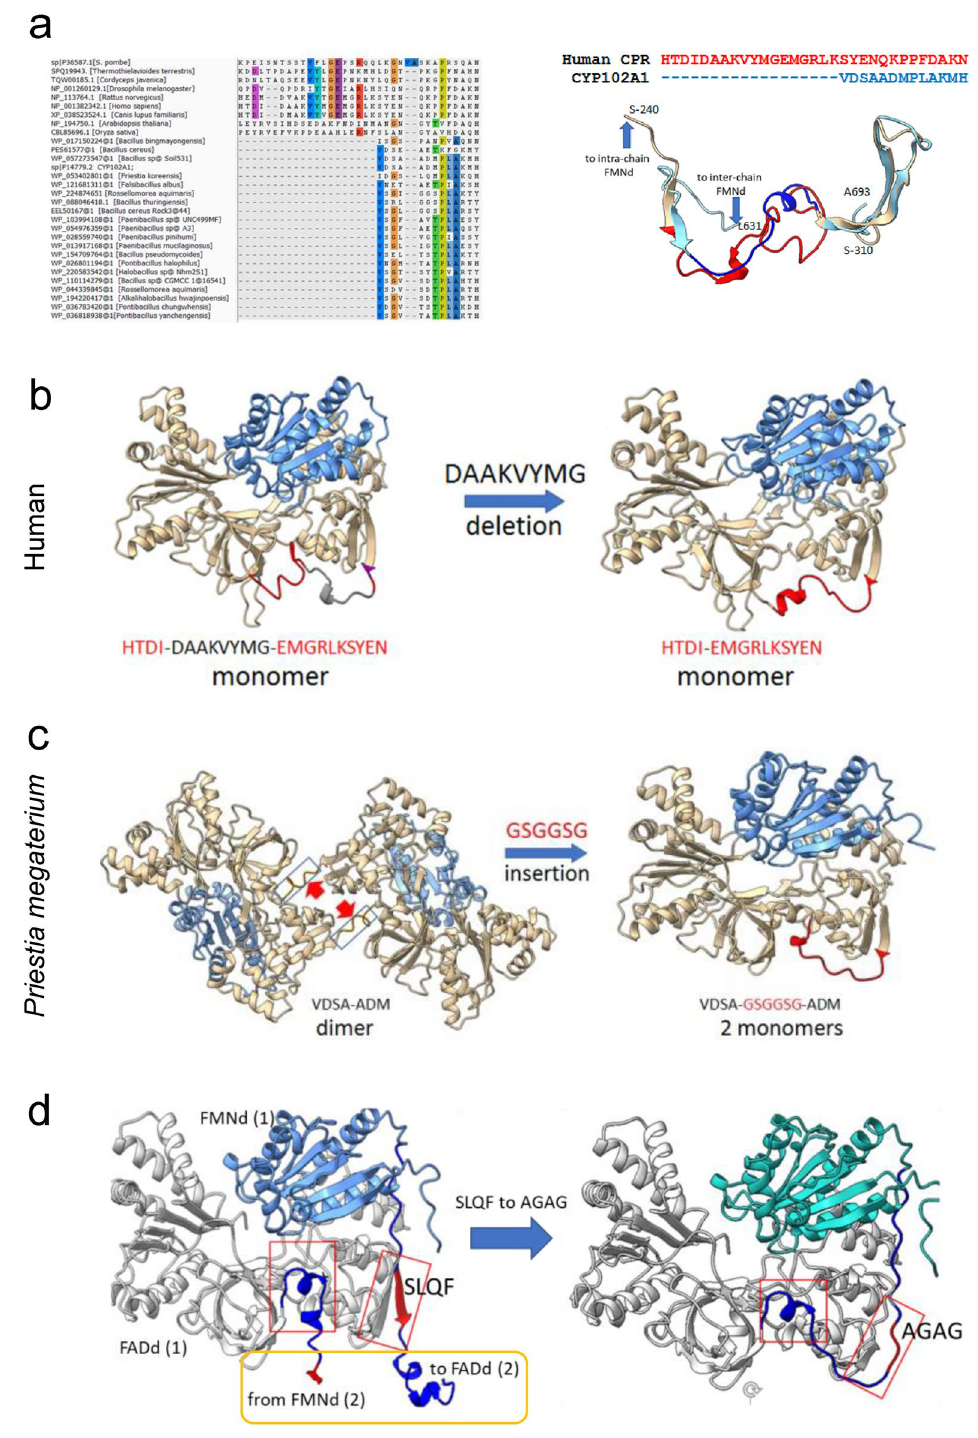
Figure 6. Structure determinants for dimerization identified by in silico mutations of human CPR and bacterial CYP102A1. ( a ), Sequence (left) and structural (right) alignments for the FMNd-FADd interdomain linker region of bacterial and eukaryotic diflavin reductase domains. Structure for human CPR (PDB 3qe2) from Ser240 to Ser310 (colored in wheat) with His250 to Asn280 part is red. The corresponding modeled structure for CYP102A1 is in pale blue with the Val648-His660 in dark blue. The common β-sheet used as alignment limits are visible on the right and left part of the red and deep blue parts. ( b ), Structural consequence of the 254 DAAKVYMG 261 sequence deletion (in grey) in the interdomain linker region (in red) of the human CPR. ( c ), Predicted structural consequence of a GSGGSG sequence insertion (in red) in the same interdomain linker region ( 648 V-M 654 , red arrows) of dimeric CYP102A1. The insertion converted the dimer into two monomers featuring similar structures with human CPR ( b , c right). ( d ), predicted structural consequences of the 644 SLQ F 647 by AGAG (in red) sequence substitution in the sequence segments (in blue) crossing the FADd-FADd interface in dimeric CYP102A1. The dimeric structure is converted into two